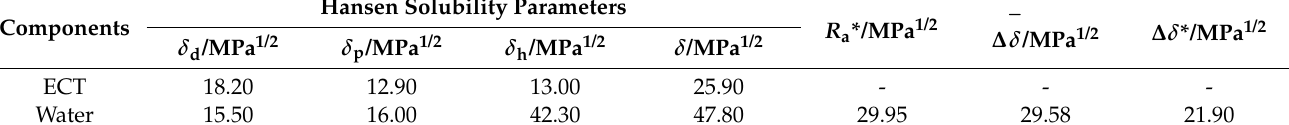
Table 3. Various solubility parameters of ECT and various PS at T = 298.2 K. Hansen Solubility Components